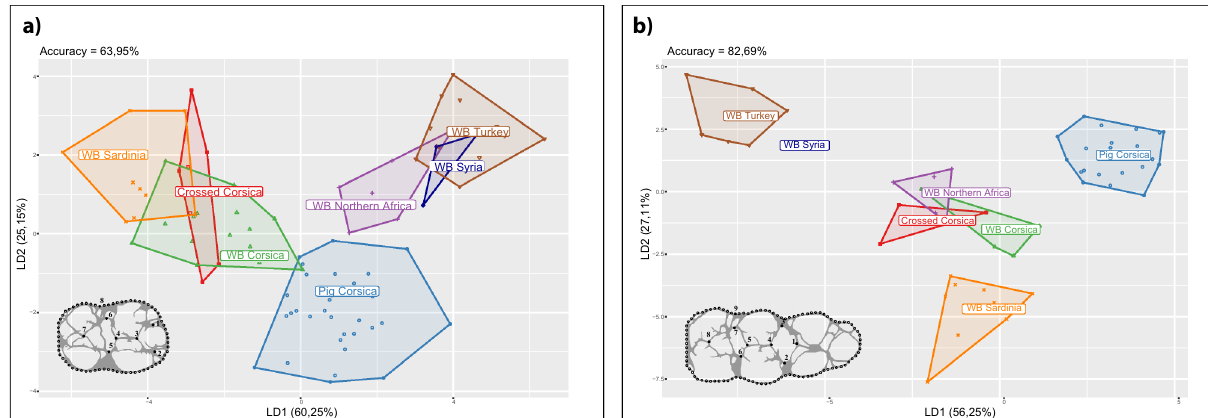
Figure 3. Sus scrofa molar form differences in extant continental and insular wild (WB) and domestic (Pig) populations. The percentage of each group’s correct classification performed after cross-validation (accuracy) is provided: (a) CVA displaying discriminant axes LD1 and LD2 for the M/2 form variation; (b) CVA displaying discriminant axes LD1 and LD2 for the M/3 form